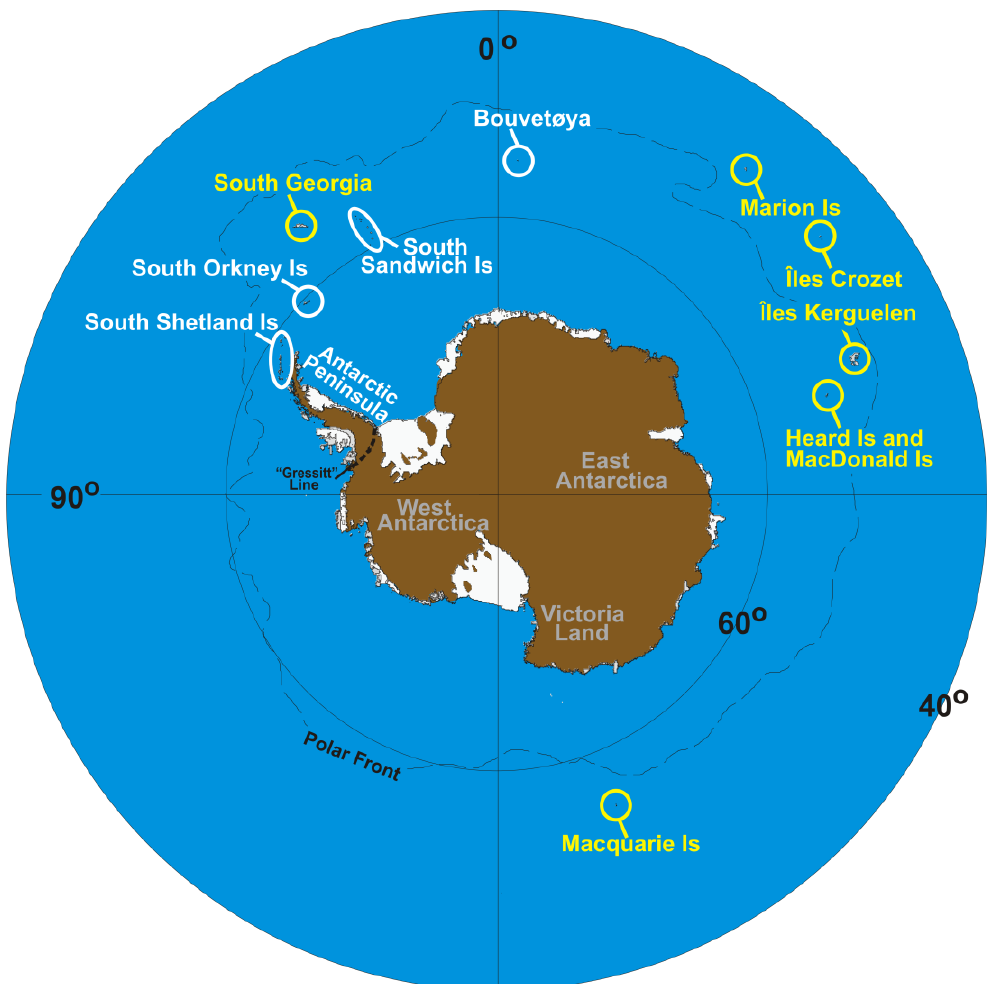
Figure 1. Map showing the different Antarctic zones and locations referred to in the text. Each zone is indicated by colour: yellow corresponds to sub-Antarctica, white to maritime Antarctica, and grey to continental Antarctica. In addition, the ‘Gressitt Line’ is shown at the base of the Antarctic Peninsula(see